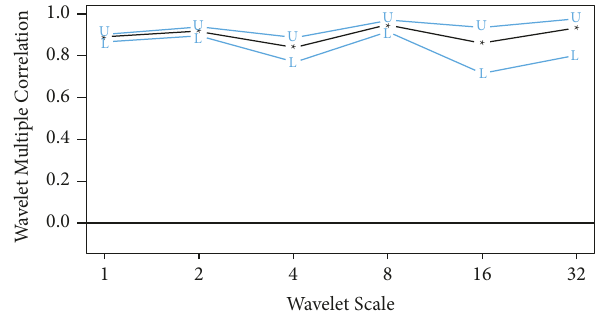
Figure 9: Wavelet multiple correlation between systematic risk of Asia (18/08/2010–03/11/2020). The blue lines denote upper (U) and lower limits (L) of the 95% confidence interval, respectively.